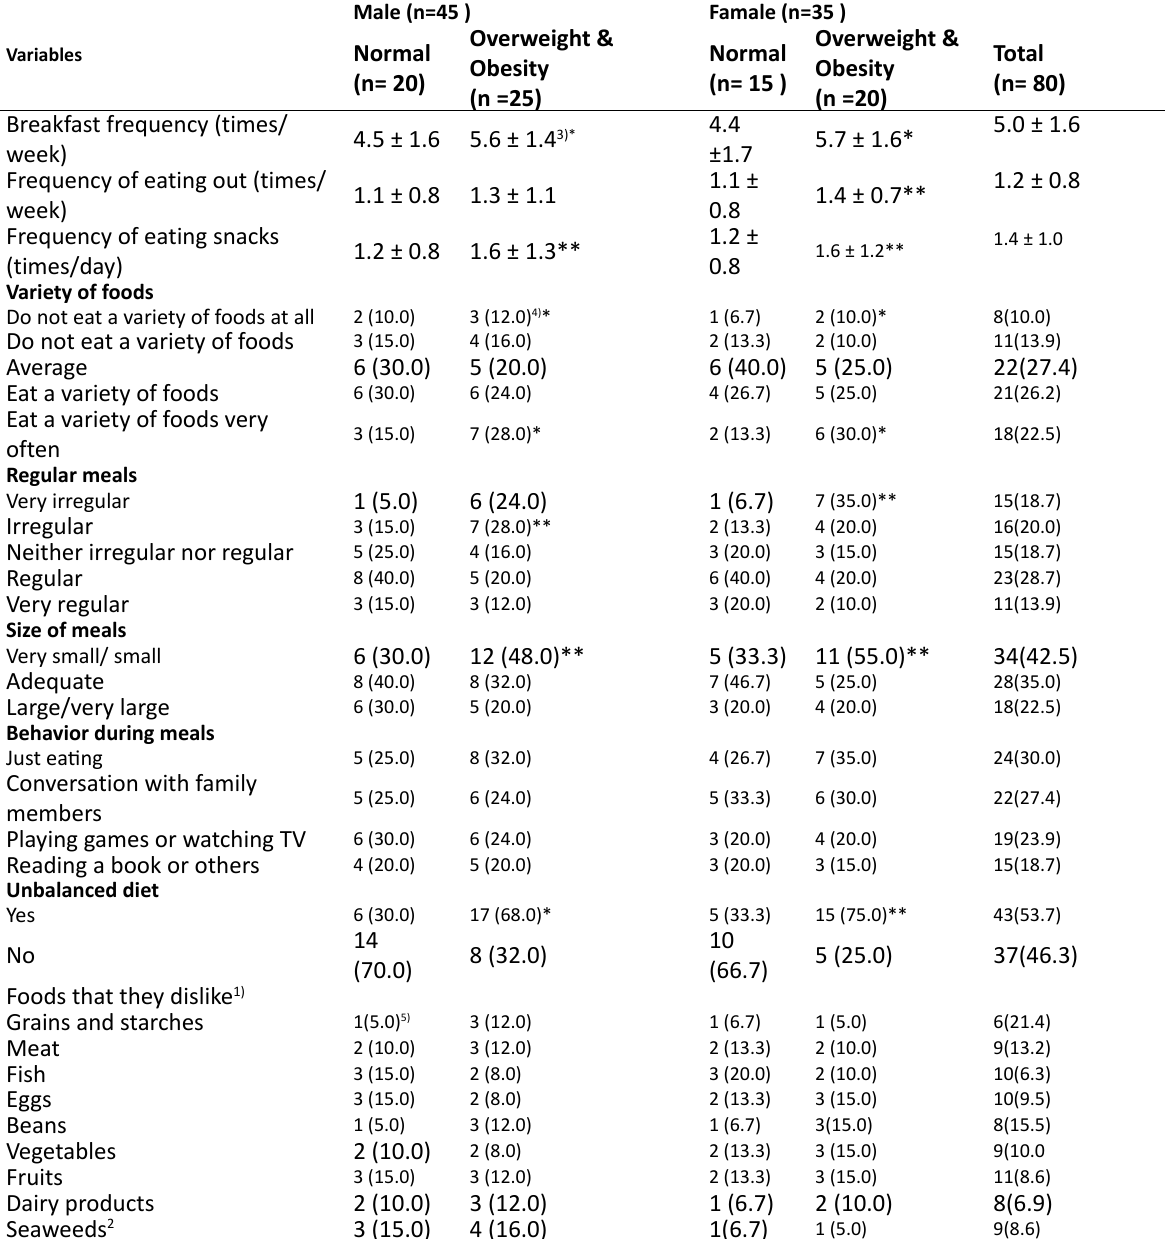
Table 2. Eating habits according to obesity status in Sedanter Individuals who are Members of Fitness Clubs